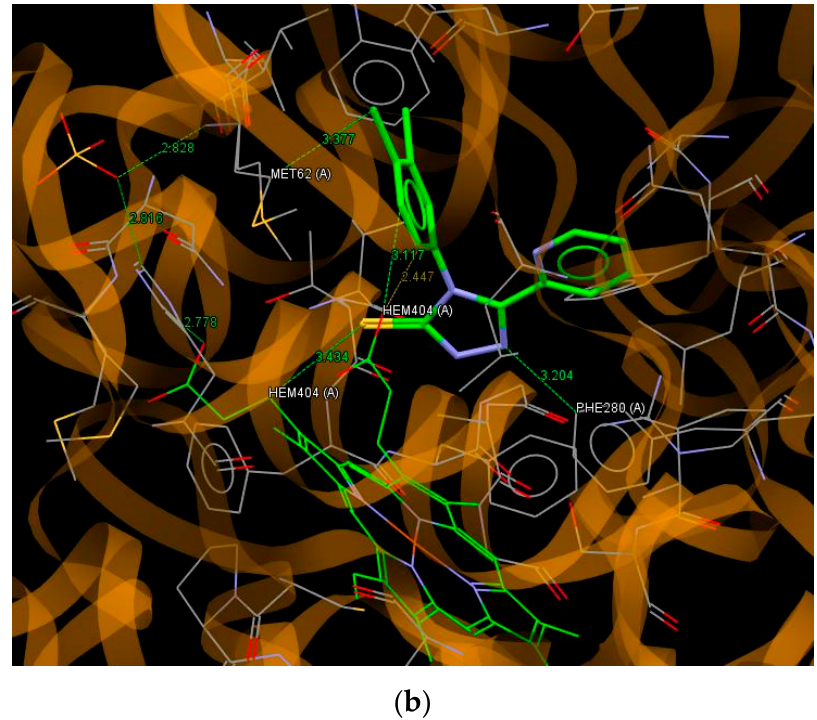
Figure 4. A view of the interaction between C14 ( a ) C4 and ( b ) and the binding site of cytochrome P450.